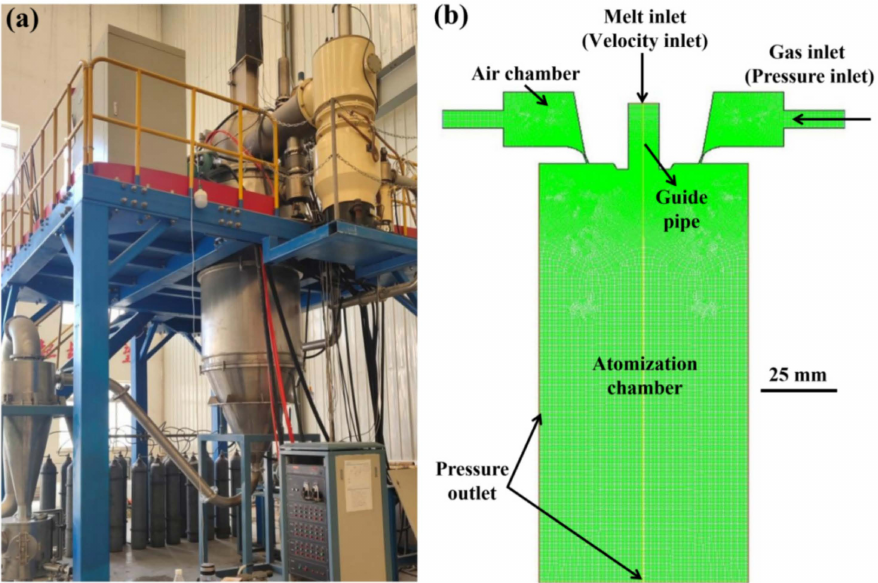
Figure 1. ( a ) Equipment illustration of the vacuum melting gas atomization pulverization. ( b ) Schematic illustration of the geometric model and meshing of the atomizing